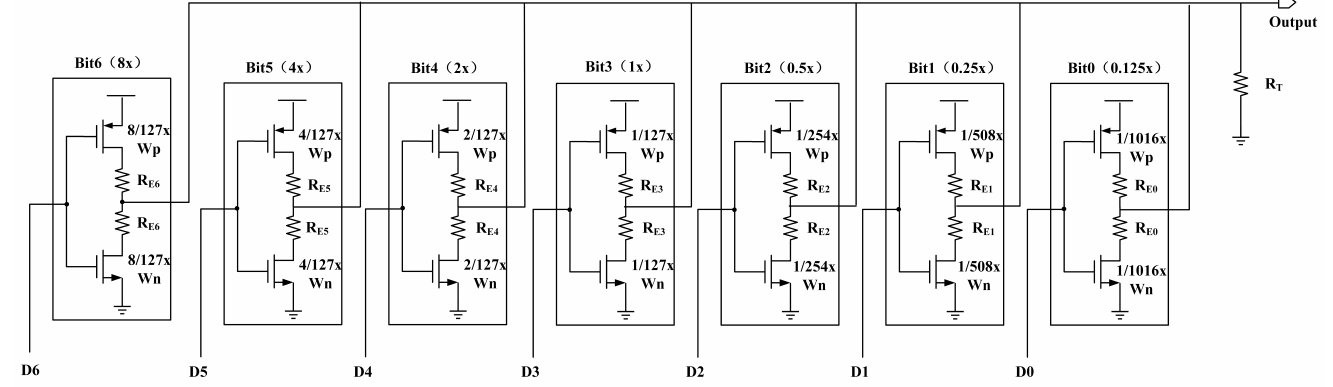
Figure 12. 7-bit SST DAC